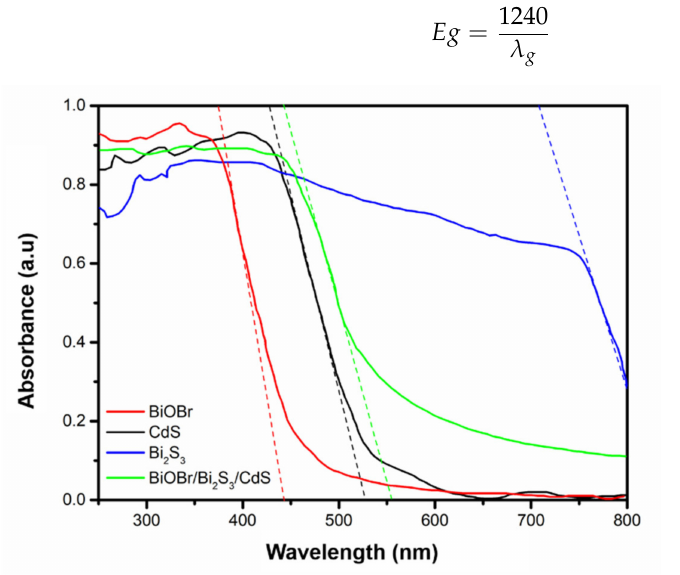
Figure 8. UV/Vis spectra of BiOBr, Bi 2 S 3 , CdS and the BiOBr/Bi 2 S 3 /CdS composite. The band edge wavelength ( λ g ) is determined by extrapolating the sharply rising part of the curve to the abscissa at zero absorption (dashed lines in Figure 8). The band gaps of pure BiOBr, Bi 2 S 3 , CdS and BiOBr/Bi 2 S 3 /CdS composites were estimated. The results showed that the band gap widths of BiOBr, Bi 2 S 3 , CdS and BiOBr/Bi 2 S 3 /CdS were 2.81 eV, 1.46 eV, 2.36 eV and 2.23 eV, respectively. This shows that the band gap energy of will help to enhance the photocatalytic performance of the